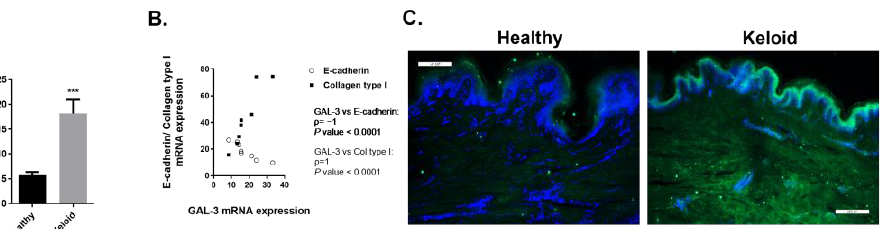
Figure 7. Galectin-3 expression is increased in skin biopsies of human keloids. Human skin tissue was obtained from healthy controls and patients with keloids. Levels of ( A ) Galectin-3 (GAL-3) messenger RNA were assessed by real-time PCR. ( B ) Correlation between levels of GAL-3 messenger RNA and E-cadherin messenger RNA or Collagen type I messenger RNA. ( C ) Representative immunofluorescence microscope images of skin sections from healthy and keloid samples for GAL-3 immunostaining. DAPI, blue nuclei. Scale 200 µm. ( A , B ) The graphs present data from n = 8 (Healthy) and n = 8 (Keloid) samples. Results are presented as mean ± SEM. Statistical analysis was performed by Mann–Whitney test (one-tailed) and with Spearman correlation. *** p < 0.001 vs. healthy control; ρ indicates Spearman’s rank correlation coefficient.